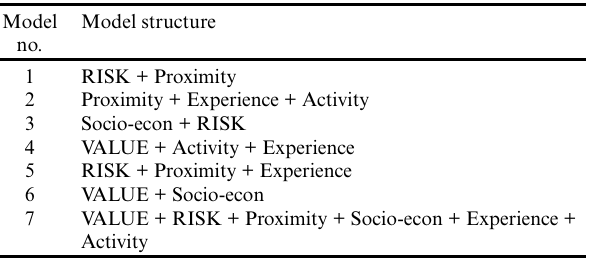
Table 2 . A priori candidate models used to explain tolerance for cougars in Clearwater County,